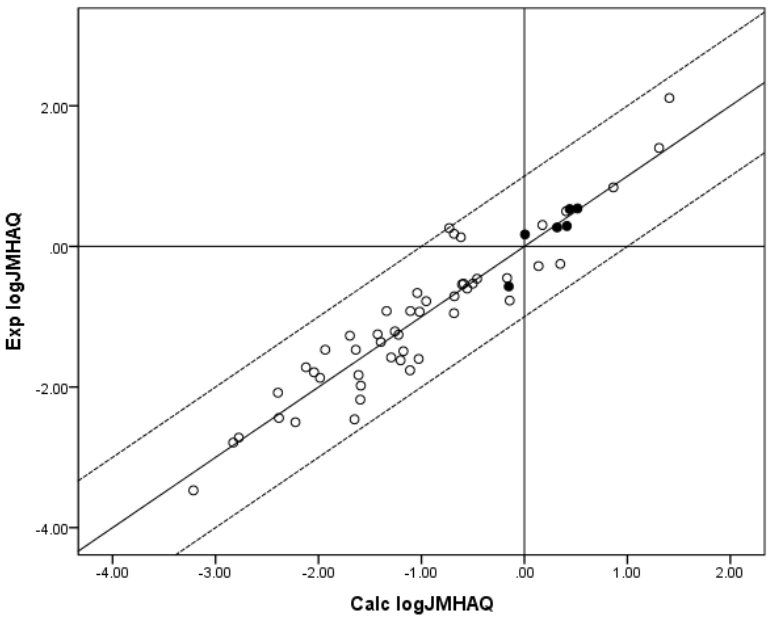
Figure 2. The correlation of the calculated (Calc.) log J from the fit of n = 55 to RS MHAQ with the experimental (Exp.) log J . The dashed lines represent the boundaries for MHAQ residual Exp. log J greater than 1.0, and the solid line indicates points where the MHAQ Calc. log J is equivalent to the Exp. log J . The filled circles indicate the n = 7 MHAQ MHAQ phenols. The Calc. log J values were determined with Equation 6: log J = −3.005 MHAQ MHAQ + 0.654 log S + 0.346 log S − 0.00112 MW, r 2 = 0.883, average absolute residual OCT AQ log J = MHAQ